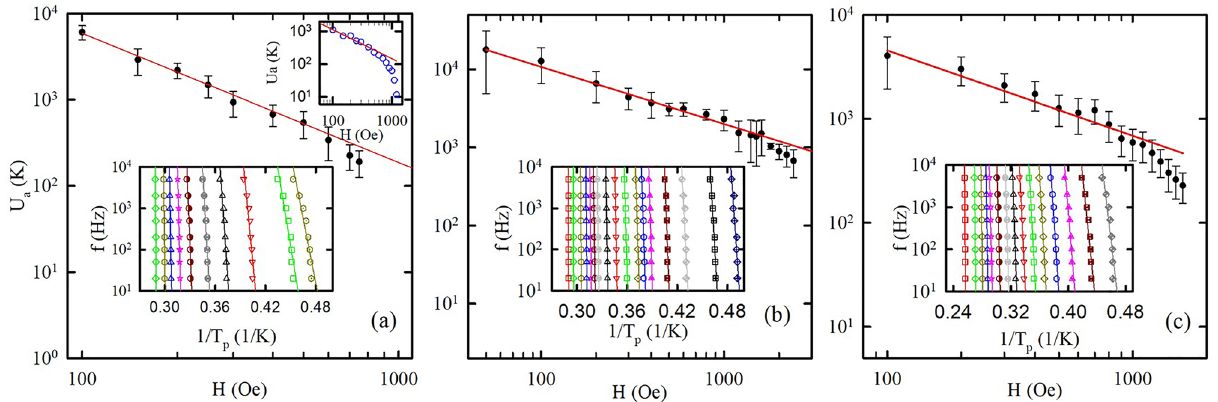
Figure 6. The bias magnetic field versus calculated activation barrier for ( a ) O-Sn, ( b ) O-In, and ( c ) O-Hg. The red straight lines are power law fits as discussed in the text. The insets show the Arrhenius plots for T p with linear fits. The upper inset in the panel ( a ) shows the variations of activation barriers with field obtained from resistance measurements for